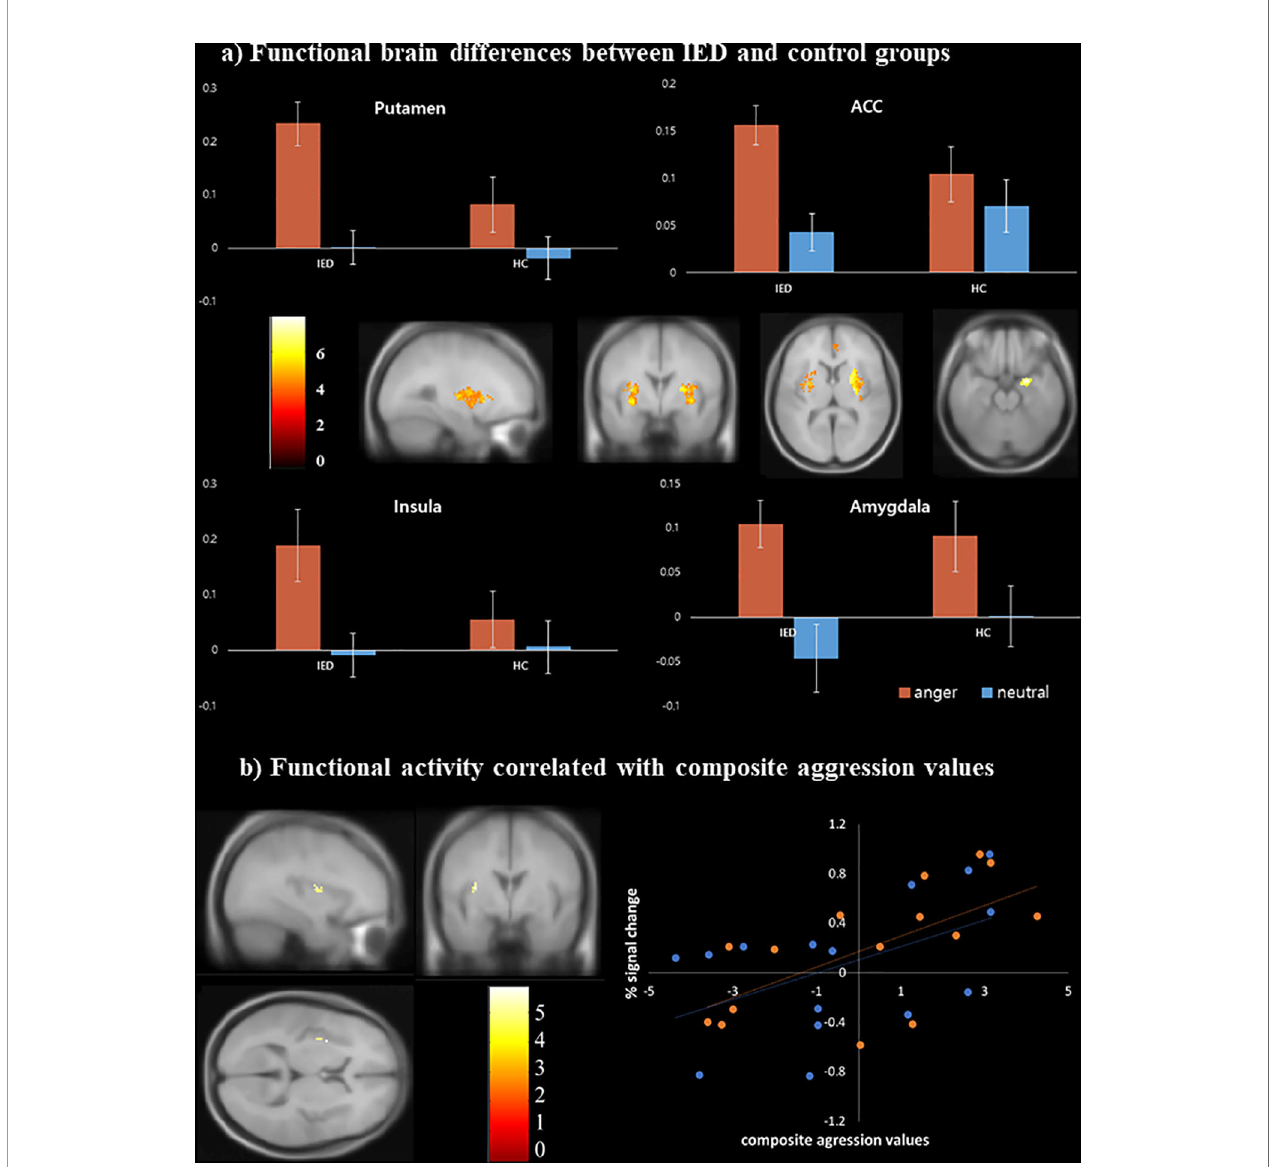
FIGURE 3 | Functional magnetic resonance imaging fi ndings of individuals with intermittent explosive disorder (IED) and healthy controls. (A) Brain areas showing increased activity in response to anger stimuli among individuals with IED compared to healthy controls [p < 0.05, false discovery rate (FDR) corrected]. (B) Scatter plots of the correlation between the composite aggression score and functional activity in the left insula (p < 0.001, uncorrected). Each orange and blue circle represents the data of an IED and control participant, respectively.